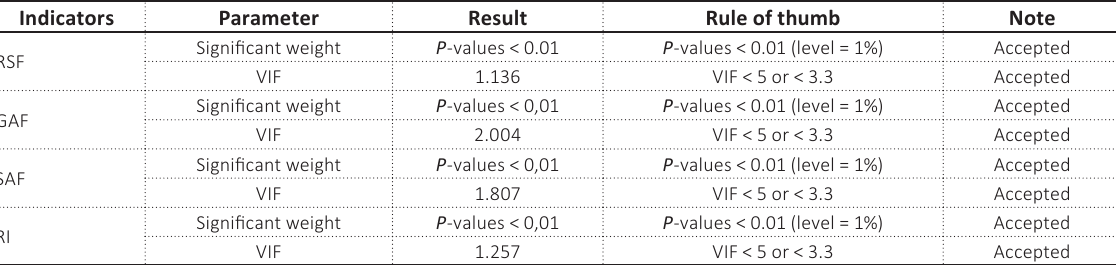
Table 2. Results of the measurement model evaluation